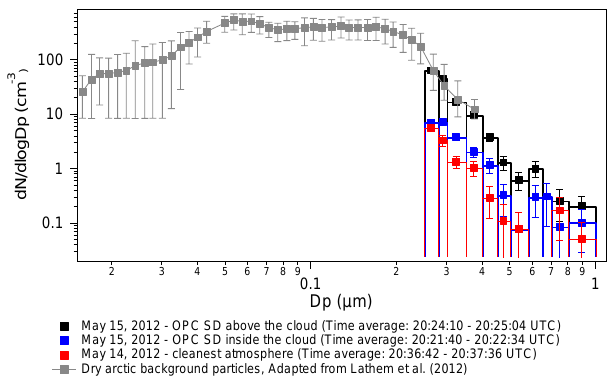
Figure 7. Cloud droplet size distributions from Flight 11 on 15 May 2012 in comparison with measurements during a cloud free, clear air situation from Flight 10 on May 14, 2012. The error bars denote the uncertainties due to the counting statistics while the width of the columns indicates the size bin limits. The data shown for sizes be- low 0.4µm (grey line and symbols) are SMPS measurements from Lathem et al. (2013) reflecting the regional background aerosol lev- els from spring time in